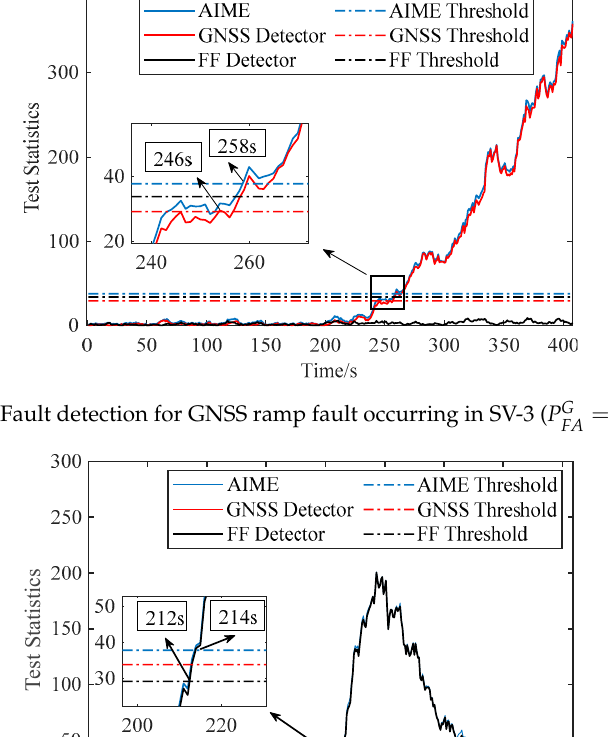
Figure 8. Fault detection for step faults occurring in accelerometer ( 𝑃 (cid:3007)(cid:3002)(cid:3007) = 0.9𝑃 (cid:3007)(cid:3002) )